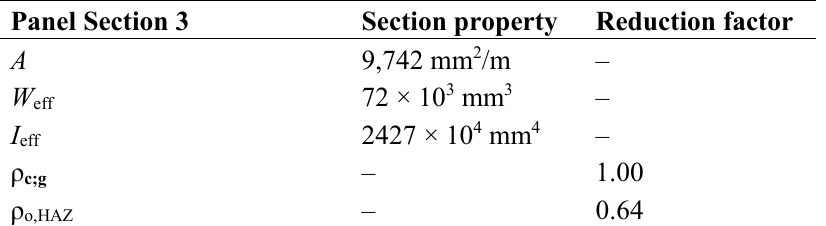
Table 9. Section properties of optimized Panel Section 4 (see Figure